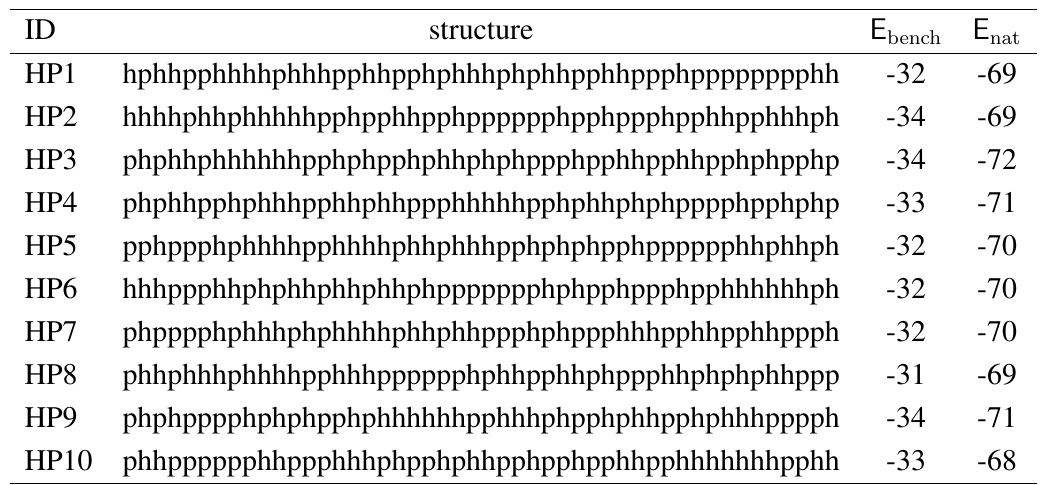
Table 1. Hydrophobic-Polar (H-P) model benchmark problems (length of 48) from [39,40]. E is the benchmark minimum on the 3D cubic lattice and E bench for the face-centred-cubic (FCC) lattice.